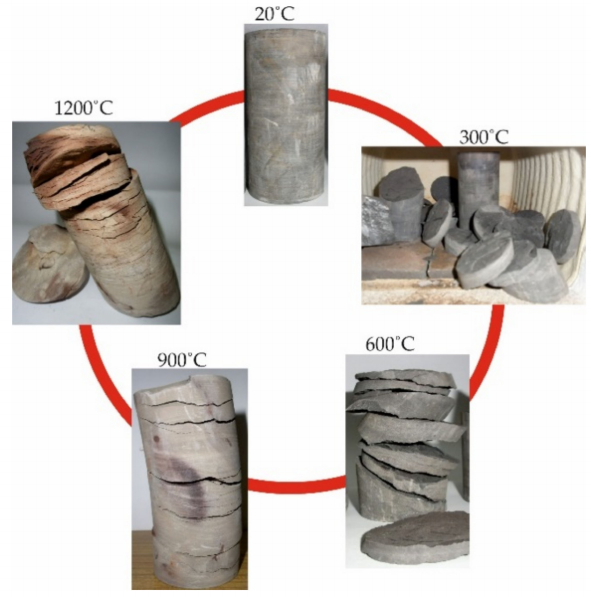
Figure 3. Claystone heated at high temperatures.